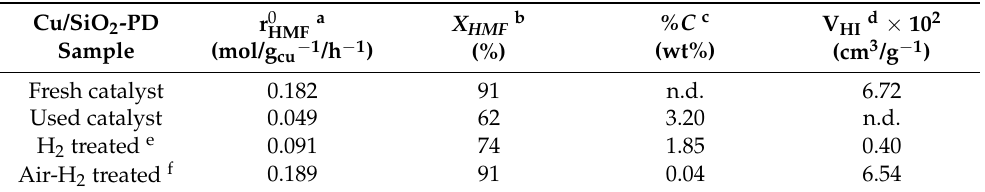
a Initial conversion rate of HMF hydrogenation. b HMF conversion after 5.5 h of reaction. c Carbon amount